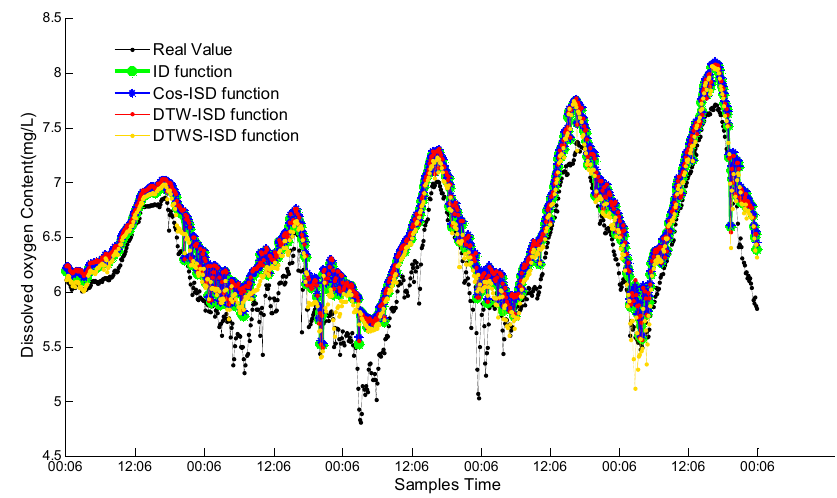
Figure 6. Weighted fusion results of four proposed functions. Table 1. Comparison of four proposed functions.